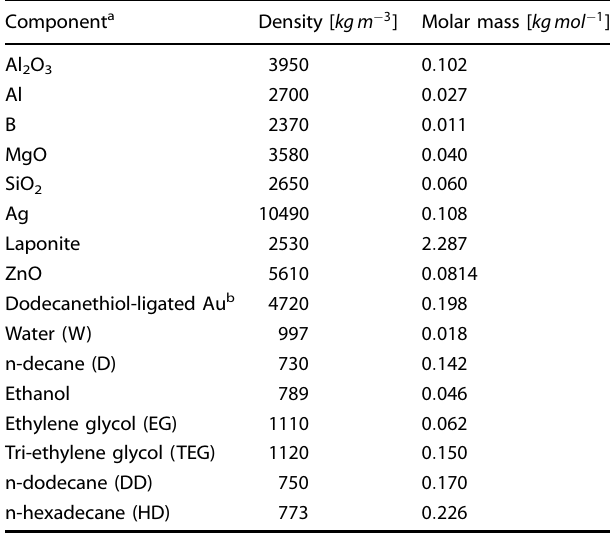
Table 1. Material properties and physical